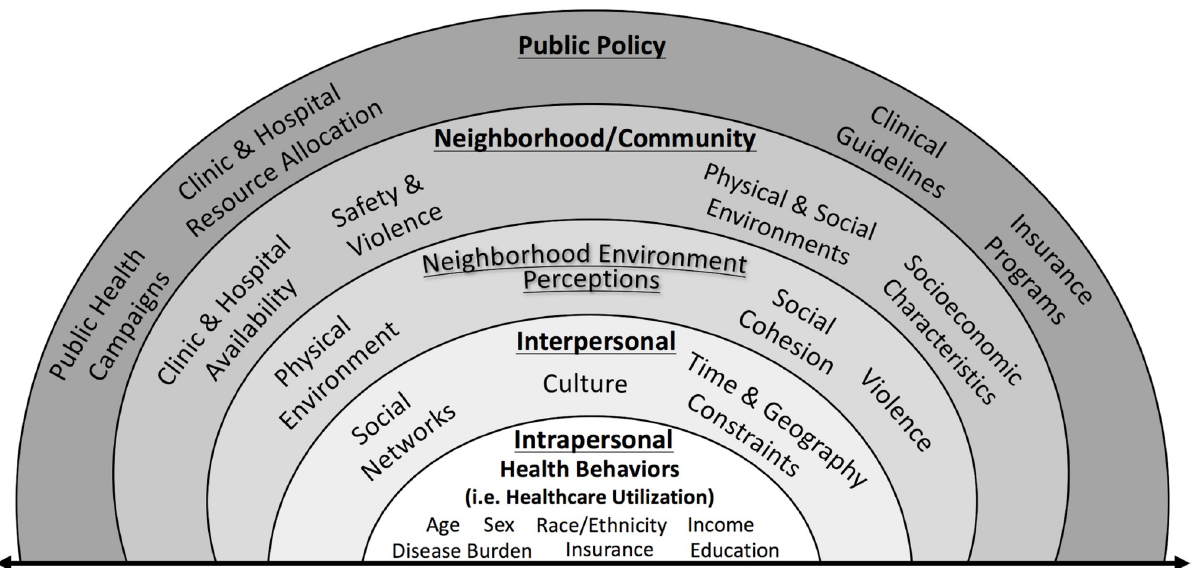
Fig 1. The socio-ecological model for health behavior. This modified socio-ecological model introduces the influence of both objective and perceived neighborhood factors which may be associated with an individual’s health behaviors, including healthcare utilization.